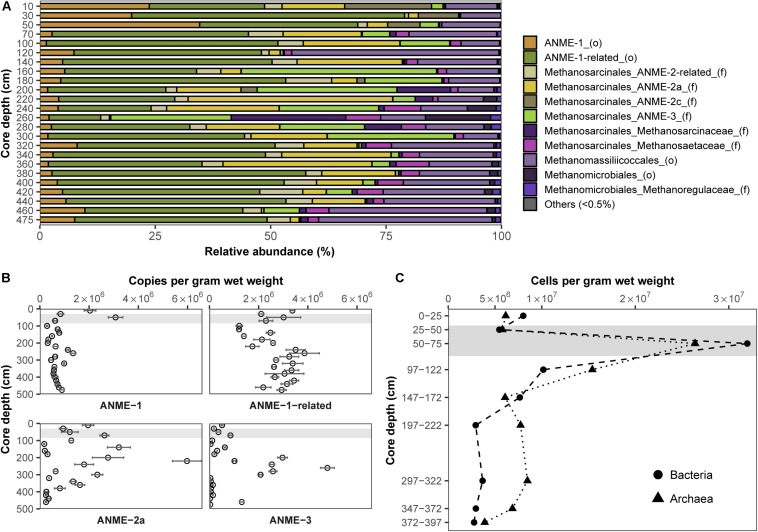
Distribution and abundance of microorganisms in the Helgoland Mud Area sediment core (HE443-010-3). Relative abundances of (A)
mcrA genes and (B)
mcrA gene copies of ANME. Error bars represent 1 s.d. of technical qPCR triplicates. (C) Cell counts of potentially active bacteria and archaea based on CARD-FISH. Gray bars within the profiles depict the SMT.